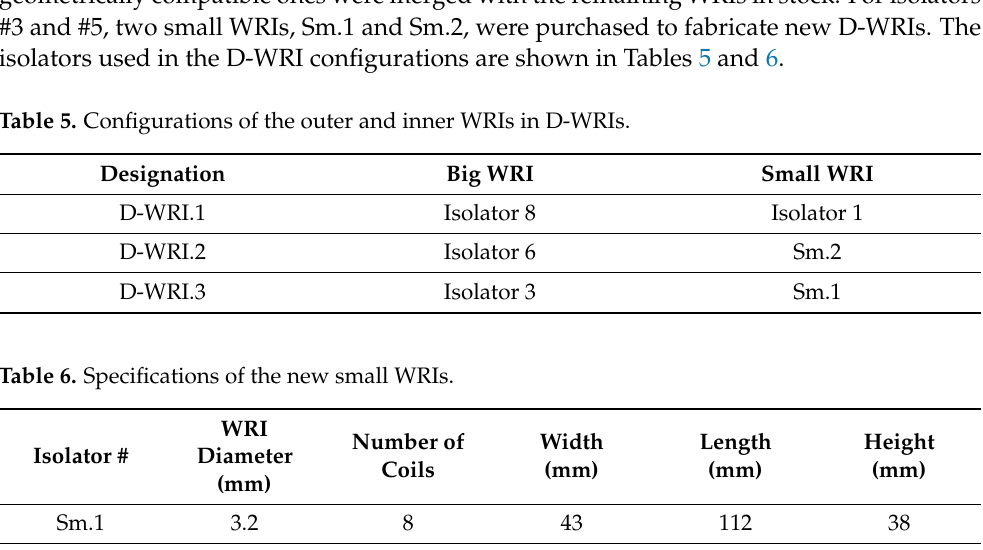
Figure 8. D-WRI: illustration and fabricated specimen. Table 5. Configurations of the outer and inner WRIs in D-WRIs.